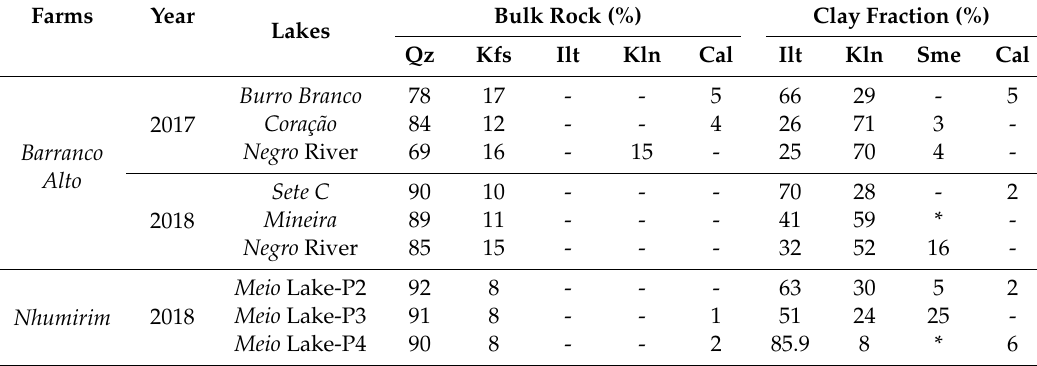
Table 4. Relative abundance of selected samples from each campaign. Qz—quartz;